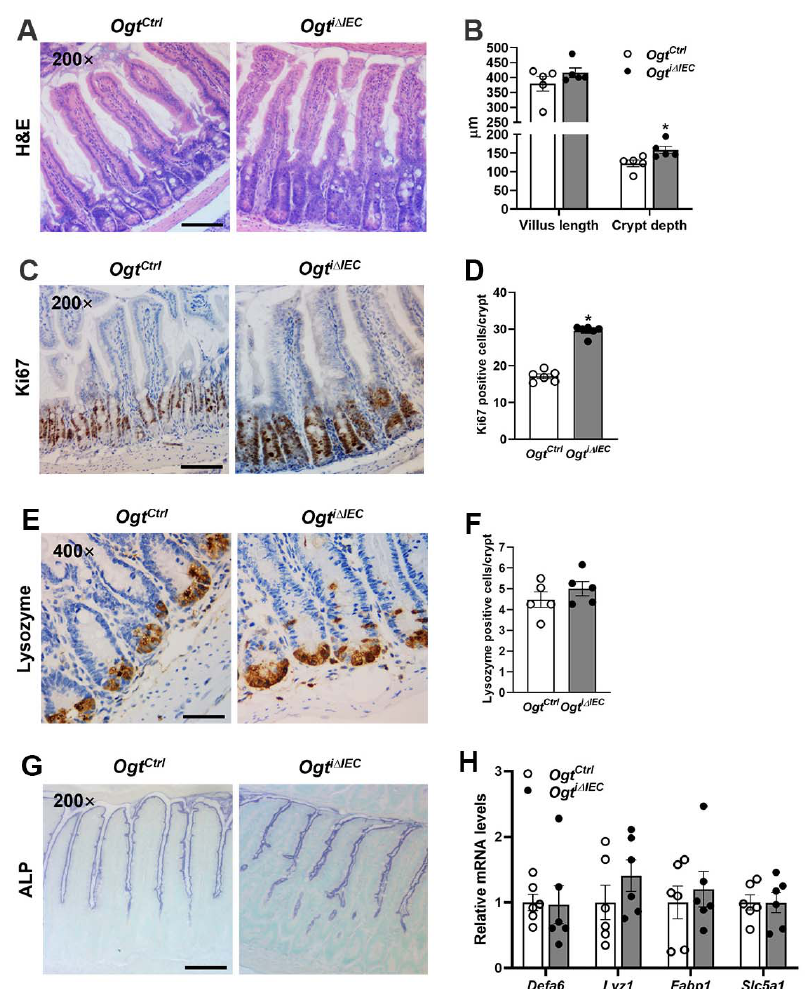
Figure 2. Deletion of Ogt in IECs of adult mice leads to abnormal epithelial architecture. The 8–10 ‐ week ‐ old male Ogt Ctrl and Ogt i ∆ IEC mice were subjected to the following analyses. ( A ) Representative H&E images of the jejunum. ( B ) Analyses of jejunal villus length and crypt depth ( n = 5/group, 30 villi or crypts counted for each mouse). ( C ) IHC staining for Ki67 in the jejunum. ( D ) Quantification